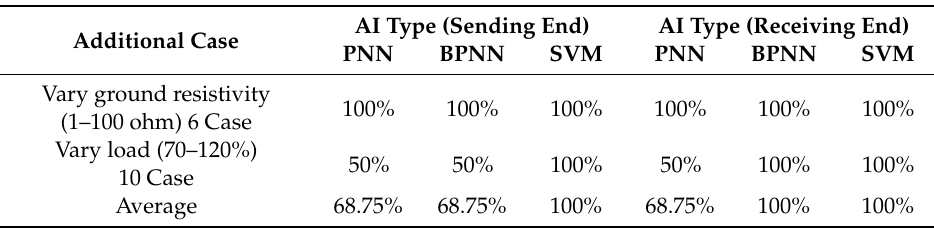
Table 3. Percentage of accurate results (additional